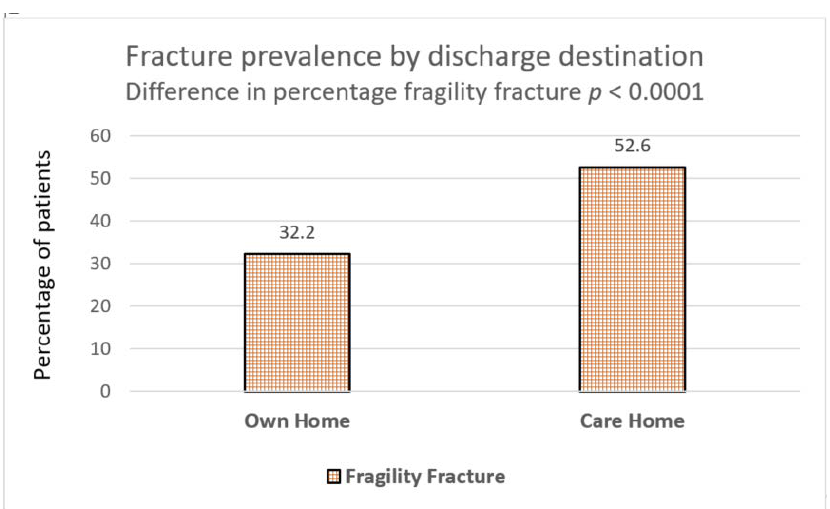
Figure 2. Prevalence of fragility fracture as defined by discharge destination following admission to hospital in acute dementia patients.